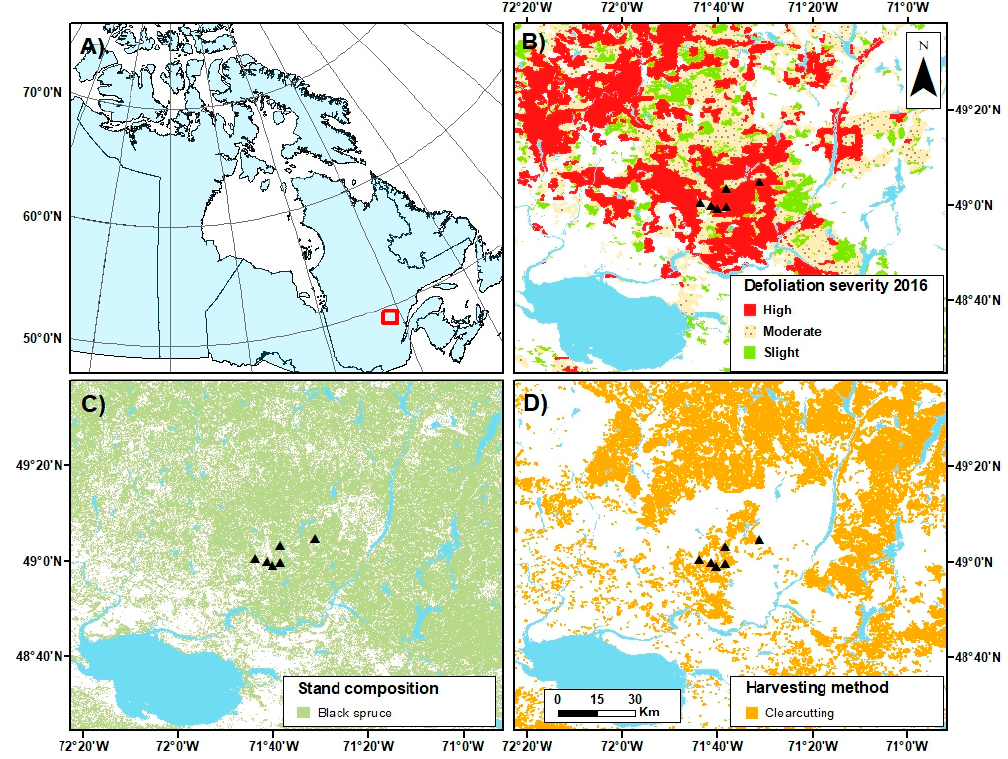
Figure 1. Location of the study area in Canada ( A ). Disposition of the experimental plots, located North of Lake Saint-Jean, Quebec, Canada in relation to Spruce budworm (SBW) defoliation severity in 2016 ( B ); species composition, where black spruce stands are represented in green ( C ), and clearcut areas are in orange ( D )